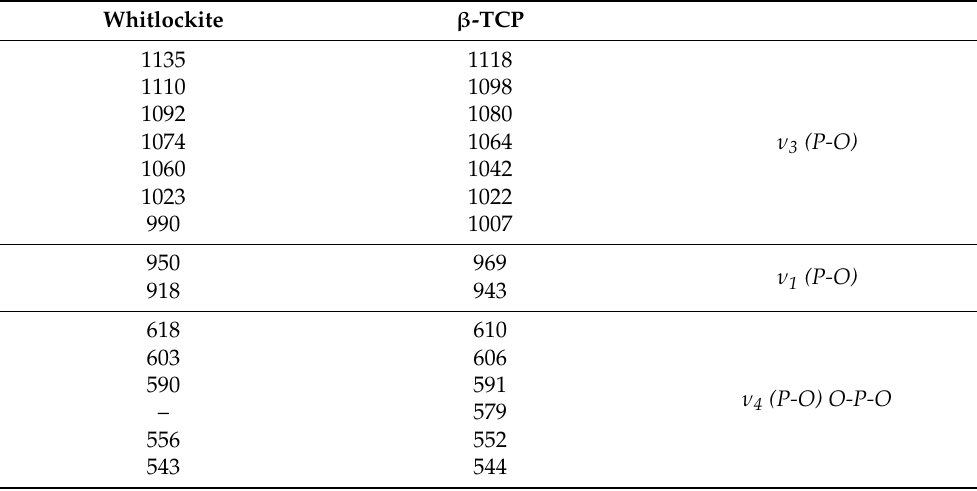
Table 7. Measured absorption in the FTIR spectrum and relative assignments for present whitlockite in comparison with data of β -TCP